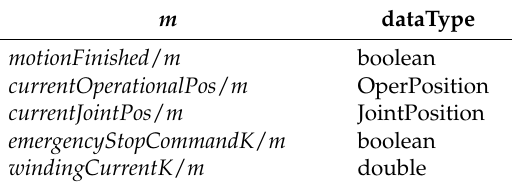
Figure 11. Definition of manip / a dataTypes. Table 4. manip / a . cs . m dataTypes.